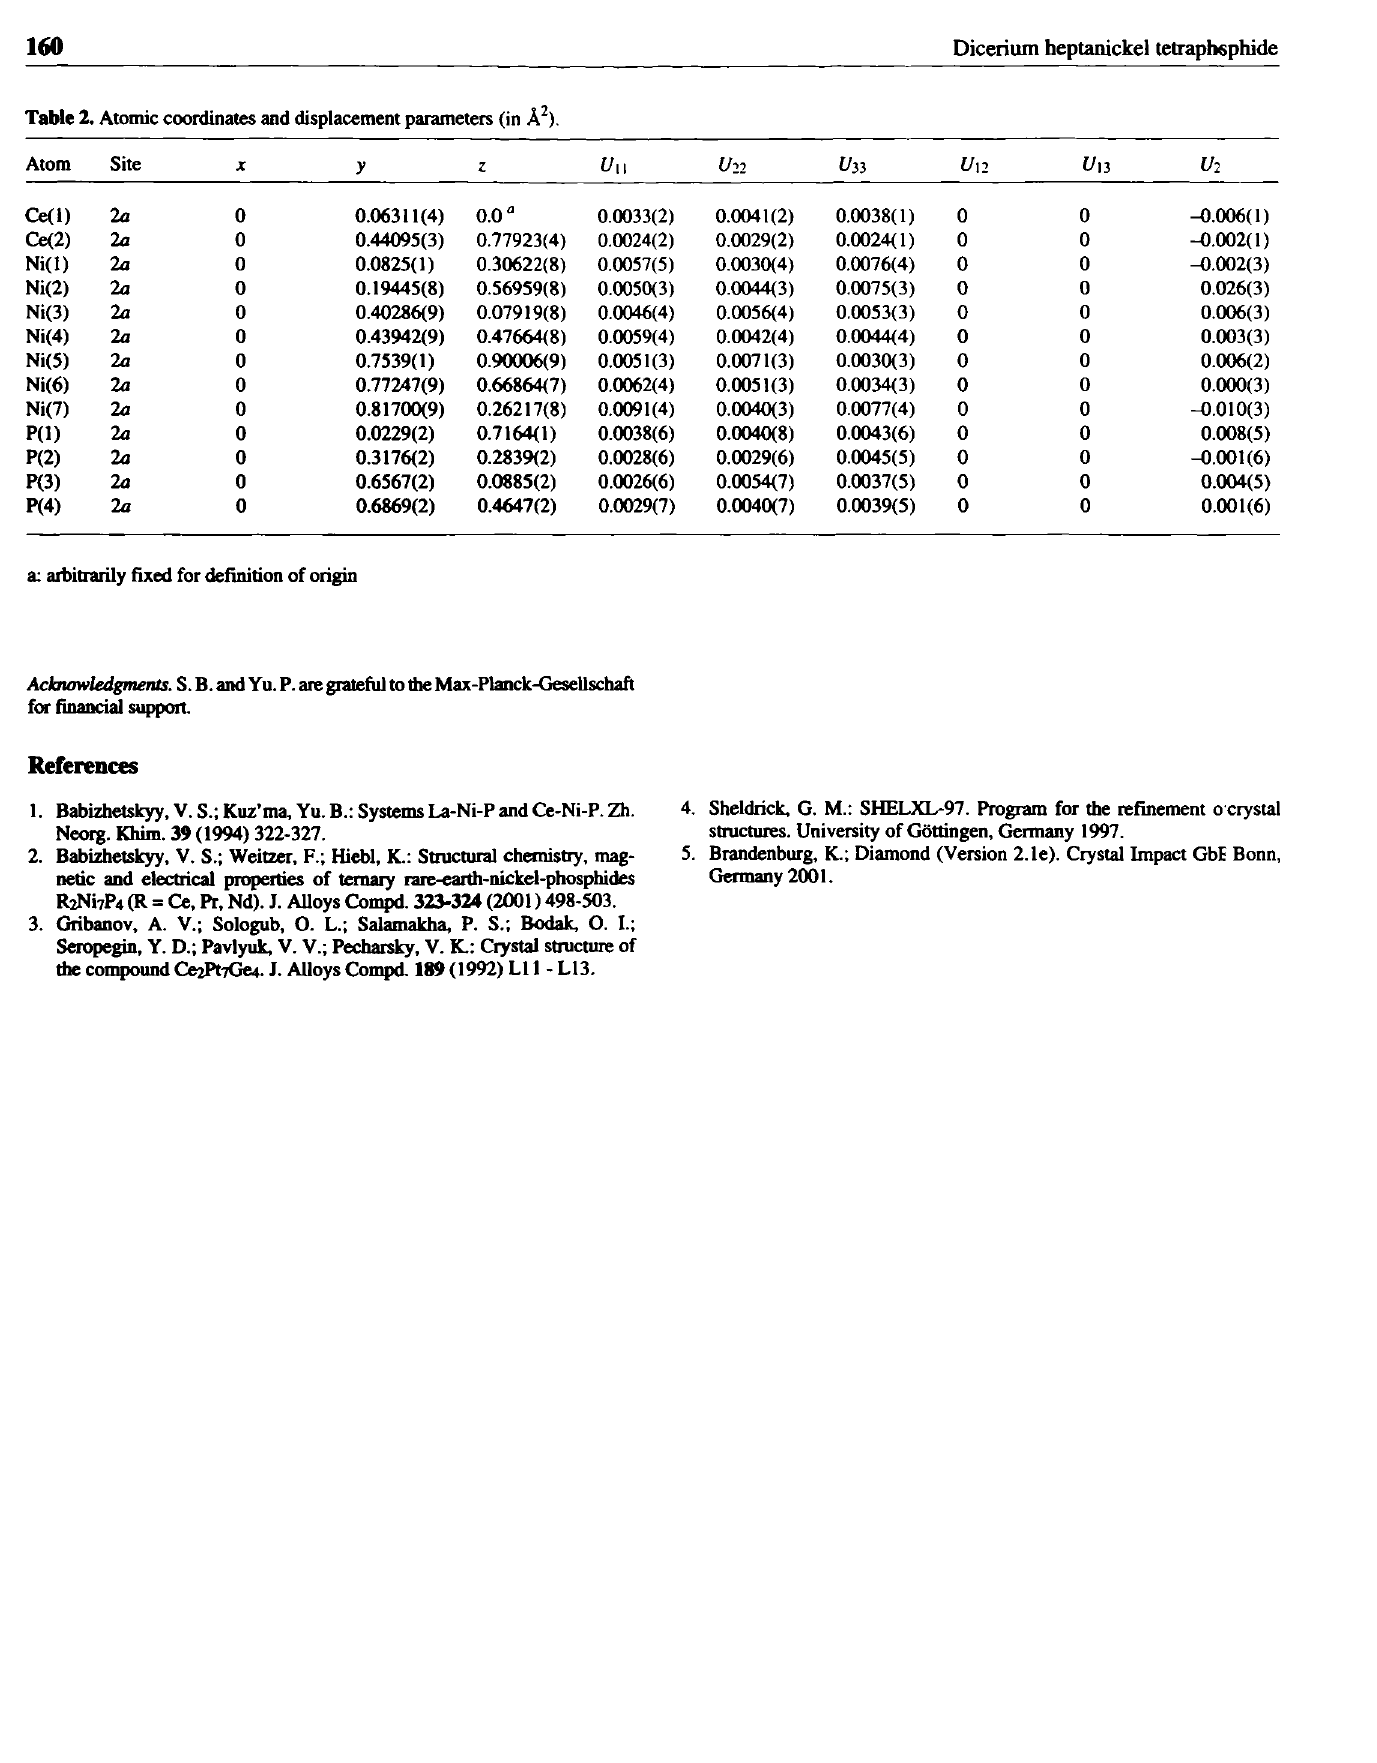
Table 2. Atomic coordinates and displacement parameters (in Â 2